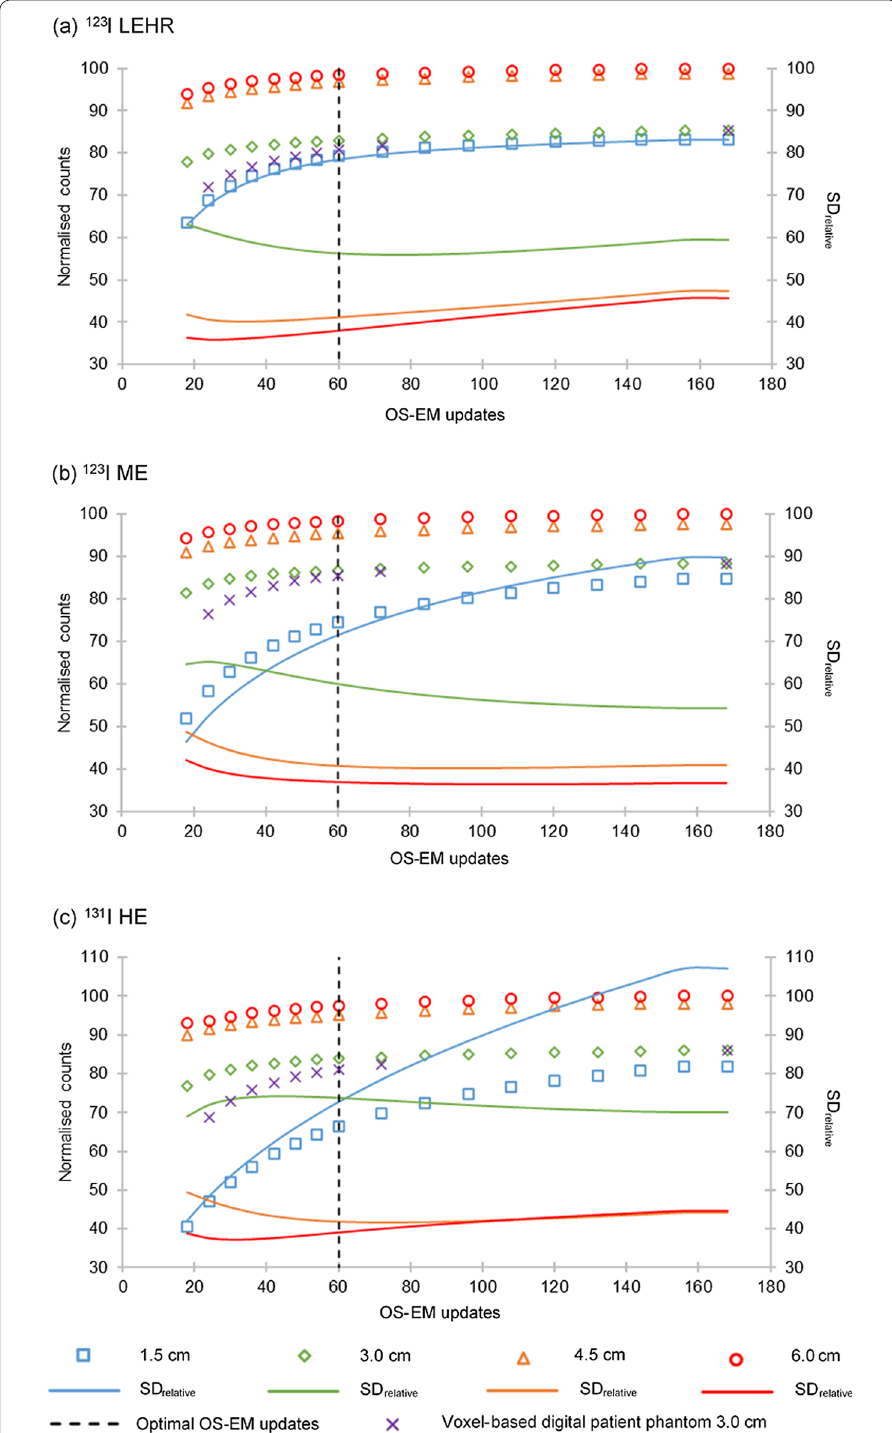
Fig. 3 Normalised counts and SD relative as a function of OS-EM updates for spheres with diameters of 1.5 cm, 3.0 cm, 4.5 cm, and 6.0 cm, for a 123 I LEHR, b 123 I ME and c 131 I